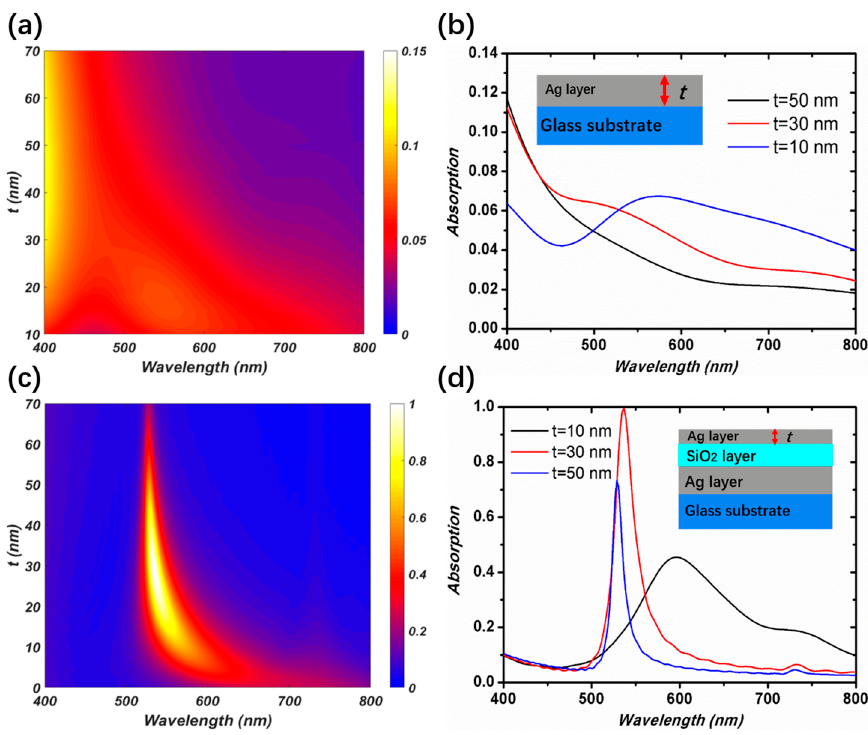
Figure 3. The simulated absorption by the FDTD algorithm. ( a ) The absorption curves when a single Ag layer coated on the glass substrate with varying thickness from 0–70 nm; ( b ) The absorption curves taken from Figure 3a when the thickness of the top Ag layer is 10, 30 and 50 nm; ( c ) The absorption as a function of wavelength of the MDM structure with a top Ag thickness from 0–70 nm when the middle SiO 2 thickness is fixed at 130 nm; ( d ) The absorption curves taken from Figure 3c when the thickness of the top Ag layer is 10, 30 and 50 nm.